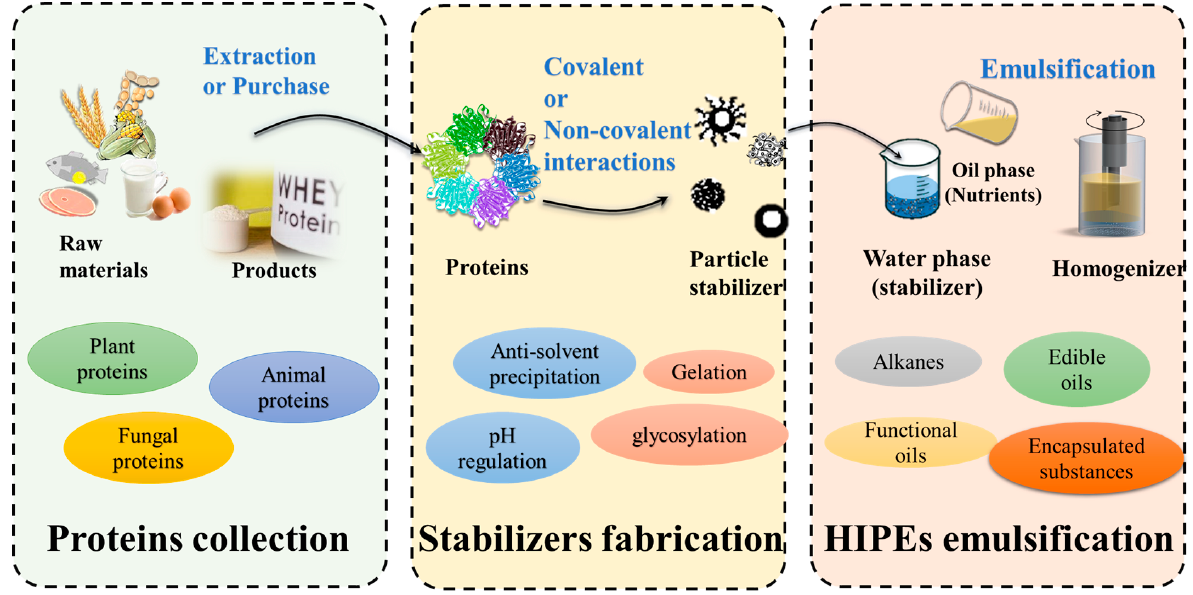
Figure 2. Preparation route of protein-based high-internal-phase Pickering emulsions (HIPEs).